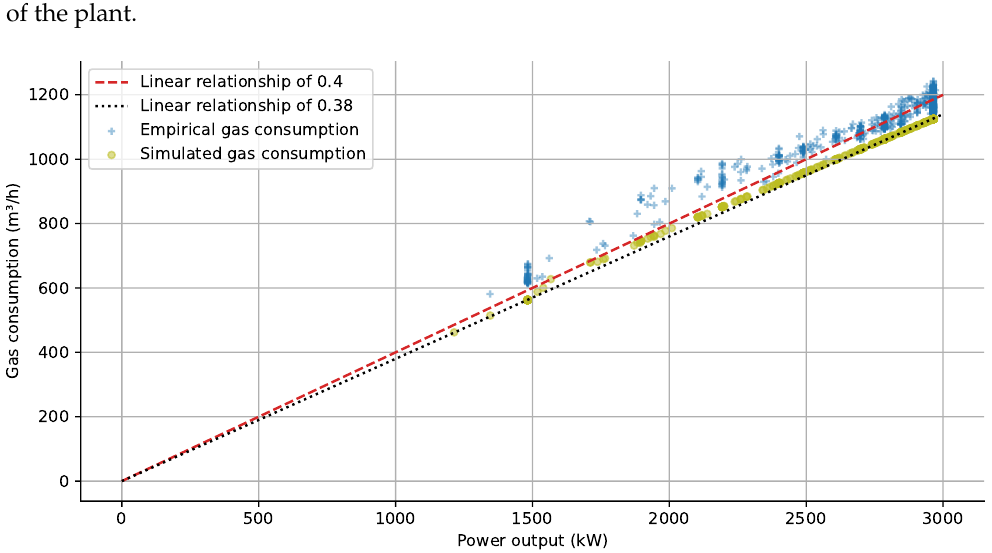
Figure 7. Comparison of real and simulated gas consumption of the two co-generation units. Figure 8 plots the electrical energy output of the plant for the month of September 2020. The hourly setpoint given to the model can be satisfied at all times, while the level of grid injection and the self-consumption of the plant can be determined with high